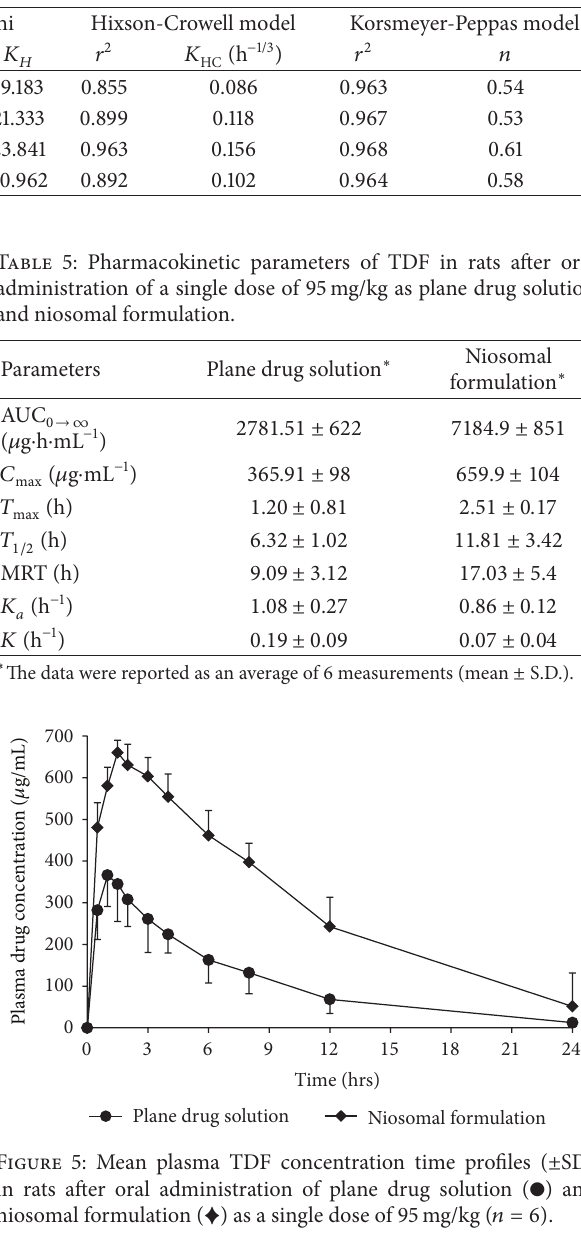
Table 4: Release kinetics of niosomal formulations.